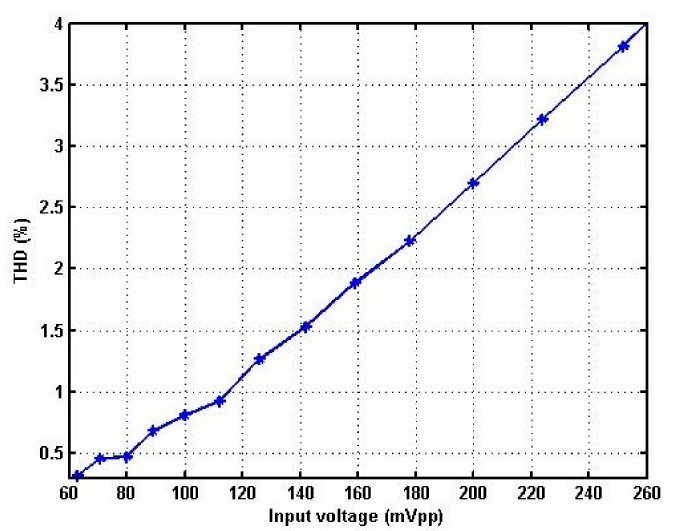
Figure 37. THD analysis results of the NBPF at the output of V BP5 with different input voltages.